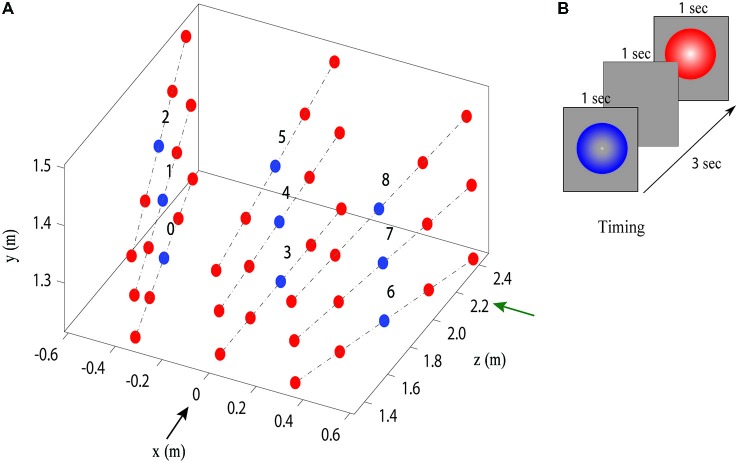
Stimulus locations and timing. (A) Stimulus lines enumerated from 0 to 8. The black arrow represents the direction of the observer’s view and the green arrow represents the big screen position for the VR setup. Red points represents comparisons and blue points represents standards. (B) Timing during one trial of the standard and comparison located at the same stimulus line.